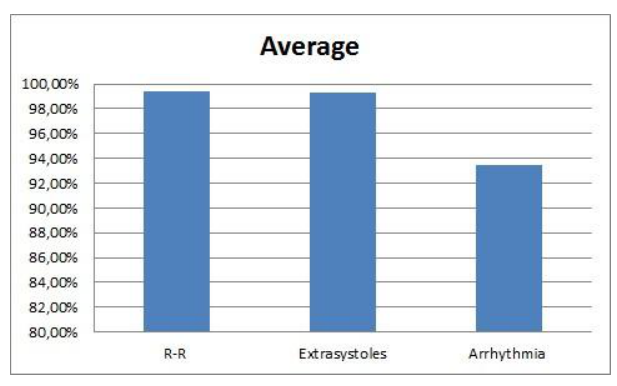
Figure 25. Success rate of the